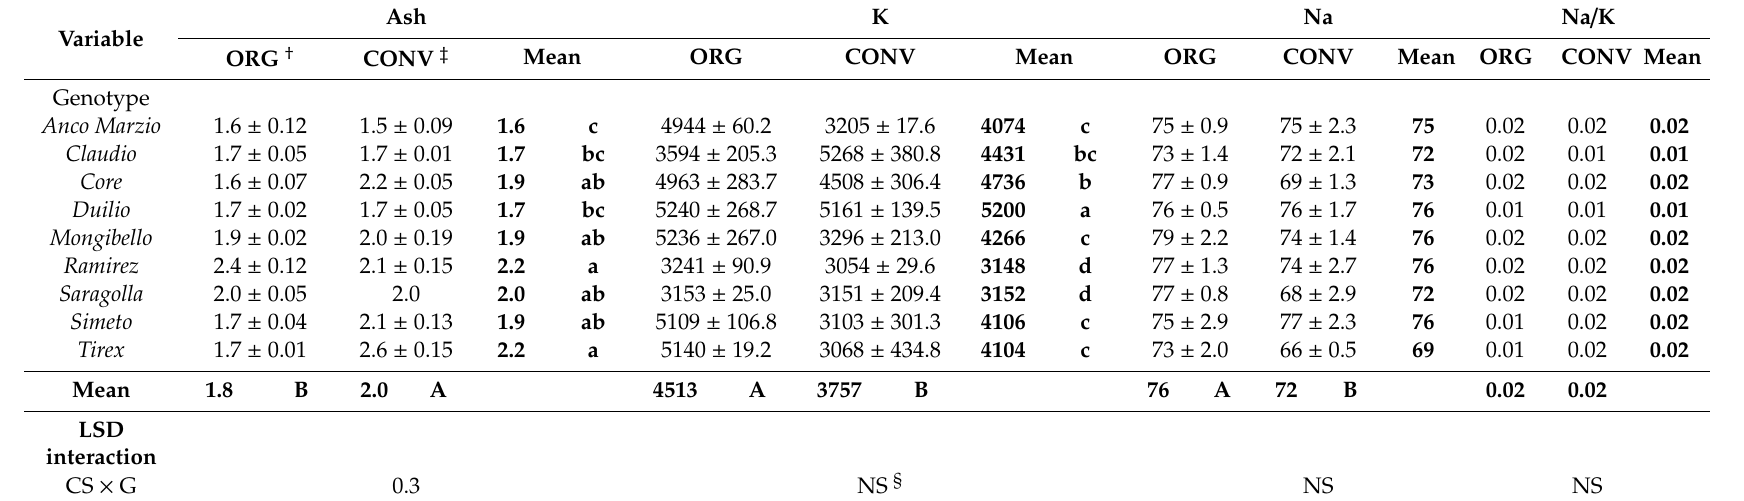
Table 4. Ash (% dry matter) and macro-minerals content (mg kg − 1 fresh weight) as a ff ected by ‘cropping system (CS) × genotype (G)’ interaction. Di ff erent letters (a–d or A, B) within each main factor indicate significance di ff erences (LSD test, p ≤ 0.05). All data are expressed as mean ± standard